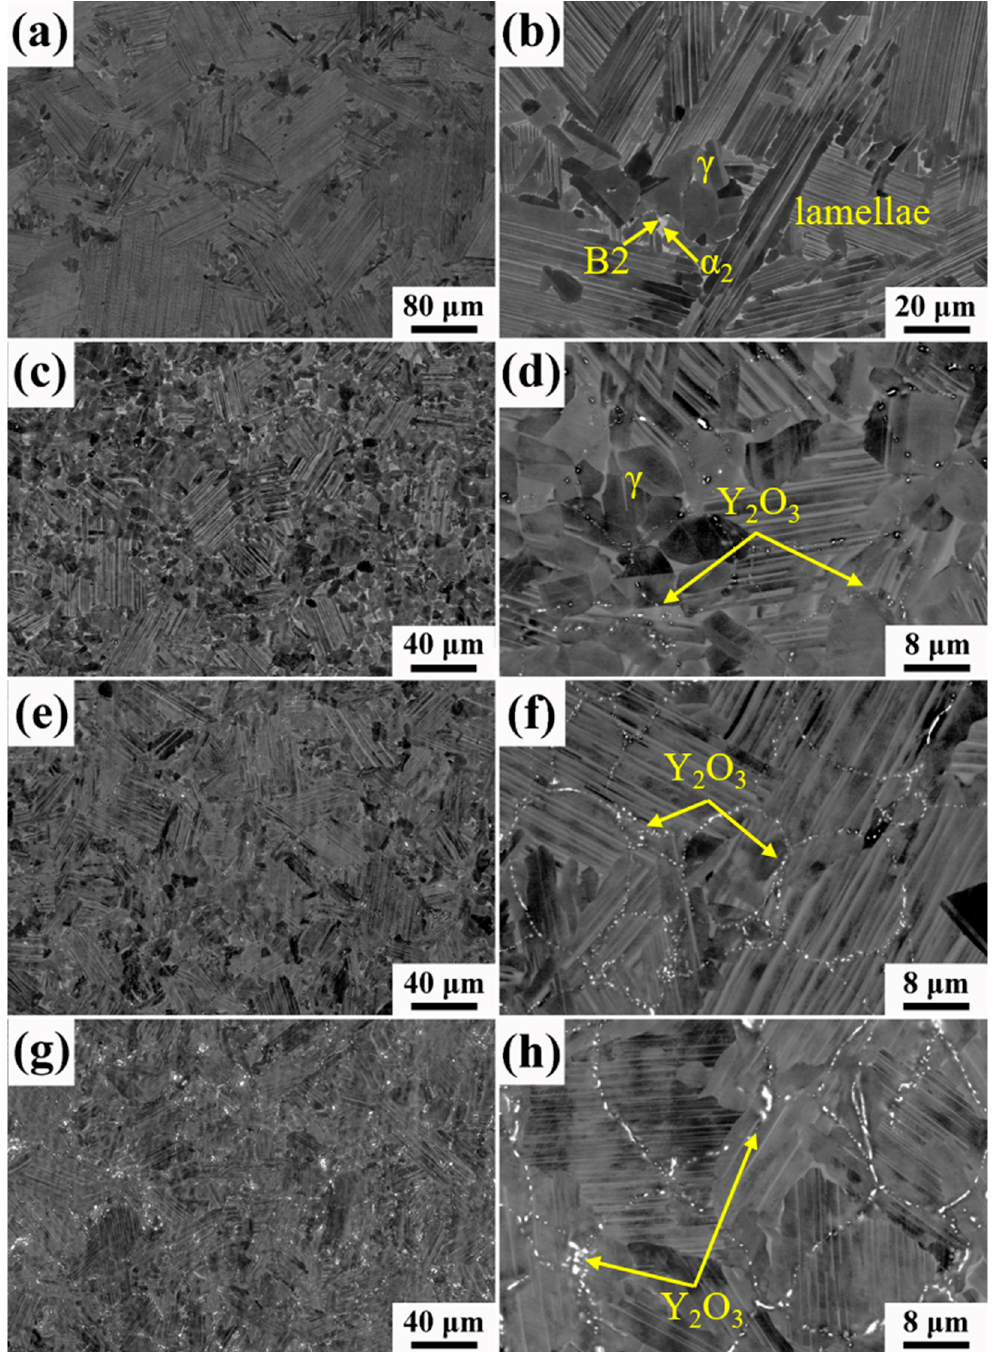
Figure 3. SEM-BSE images of samples adding difference content of nano-Y 2 O 3 ( a , b ) 0 at%; ( c , d ) 0.05 at%; ( e , f ) 0.10 at%; ( g , h ) 0.20 at%.